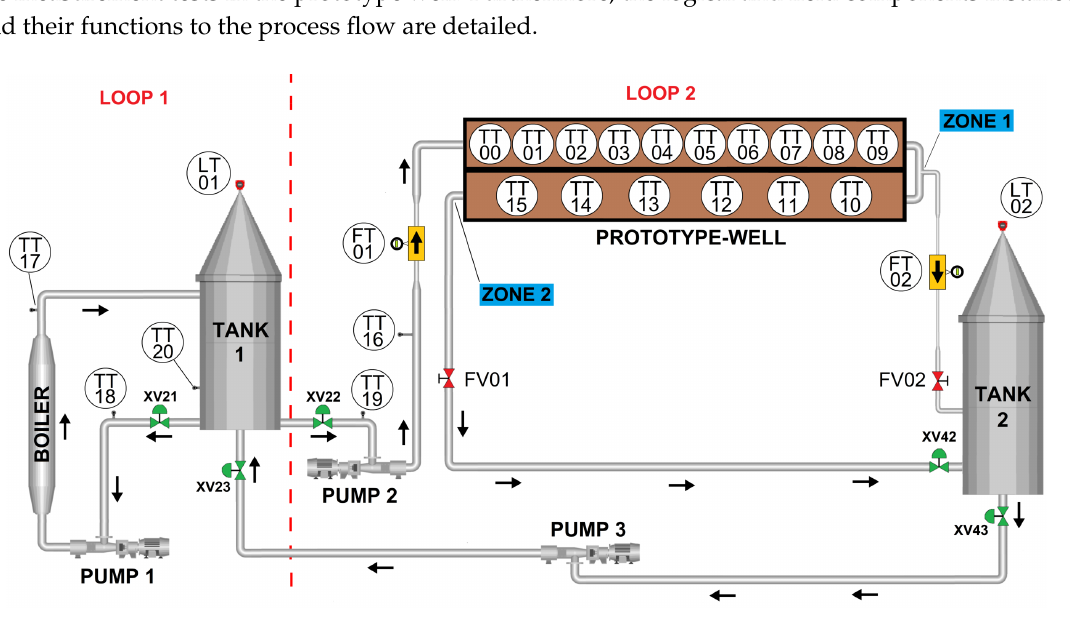
Figure 5. Instrumentation diagram of the experimental plant with an indication of the operation